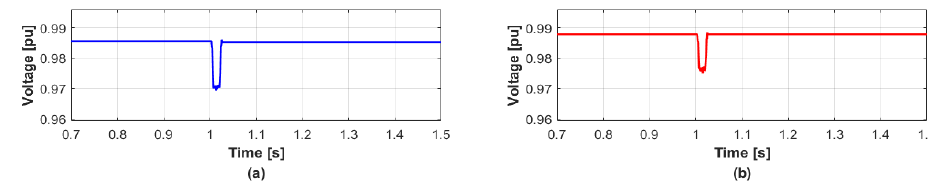
Figure 7. Voltage responses without the reactive power compensation in Case 2. ( a ) Bus 2 ( b ) Bus 3.